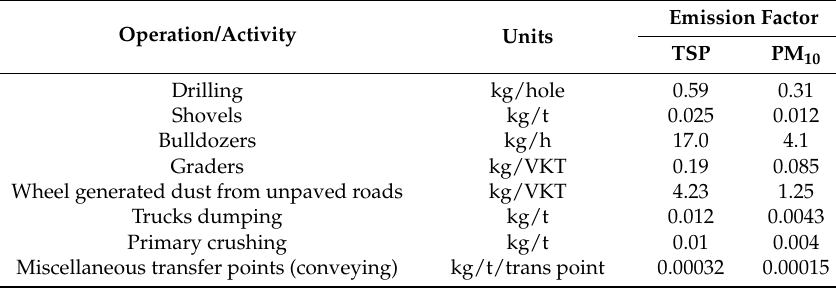
Table 2. Dust Emission Factors for Various Operations at Mines [27,28].